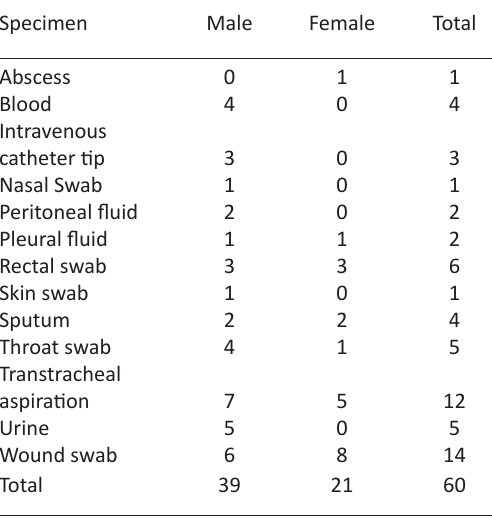
Table 2. The distribution of A. baumannii strains in Table 1. The distribution of A. baumannii in clinical